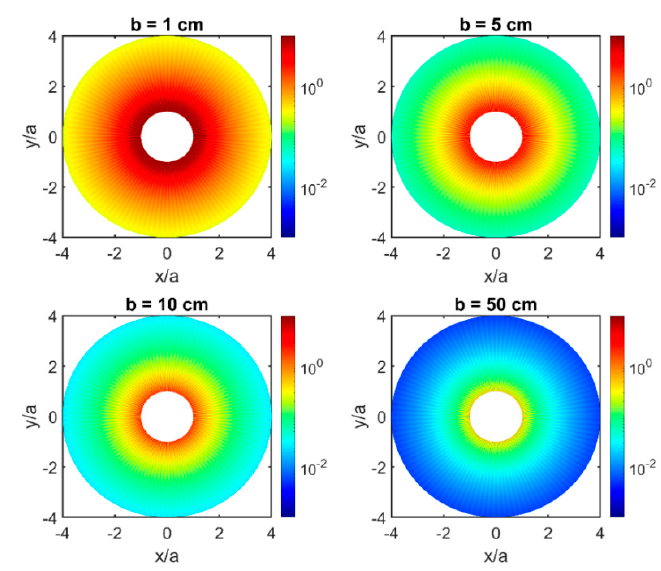
Figure 3. Contours of Equation (26) for increasing values of b assuming D 50 = 1 mm and V 0 = 1 m / s.